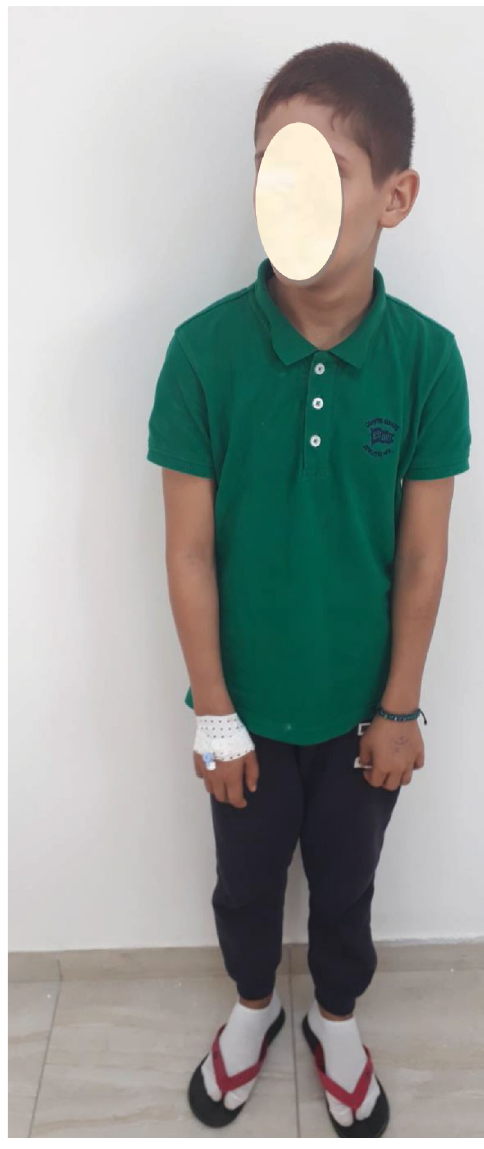
Figure 1: Physical examination of the patient showing a short